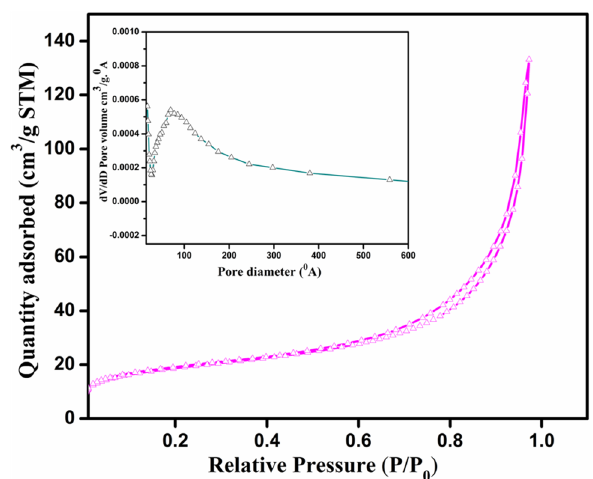
Fig. 9 BET of ZnO